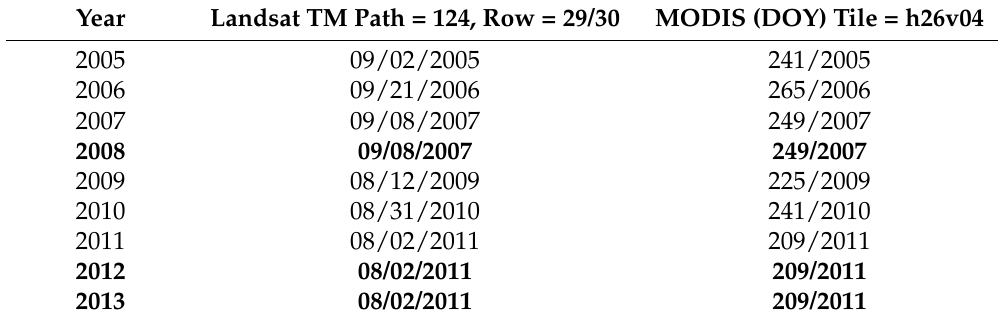
Table 1. Landsat and Moderate Resolution Imaging Spectroradiometer (MODIS) image pairs for generating synthetic Normalized Difference Vegetation Index (NDVI) data during 2005–2013. Years highlighted with bold font lacked Landsat images, and therefore, the Landsat images from adjacent year (1-yr interval) or 2-yr intervals were